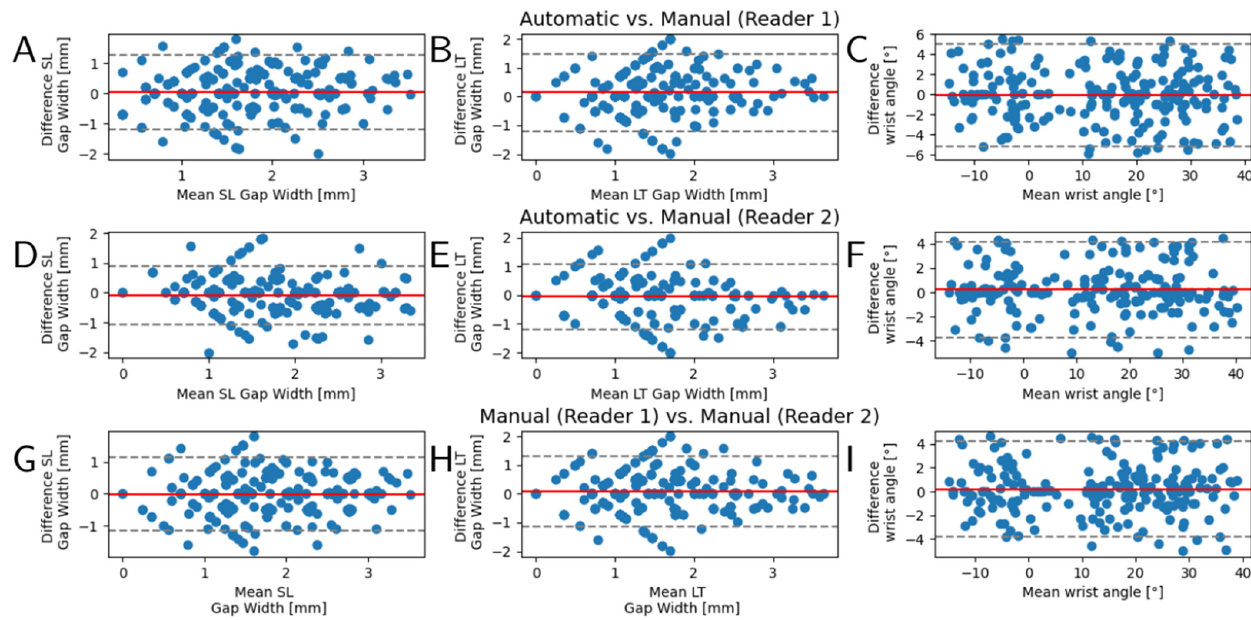
Figure 5. Bland–Altman plots to evaluate inter-method and inter-reader reliability. Automatic segmentations and subse- quently determined diagnostic measures, i.e., scapholunate (SL) gap width ( A , D , G ), lunotriquetral (LT) gap width ( B , E , H ), and wrist angle ( C , F , I ), were evaluated against the manual reference measurements by two radiologists (reader 1, reader 2). Y-axes indicate the respective measures’ inter-method or inter-reader differences, while x-axes indicate the mean measure. Visualized are the 210 values of the test datasets as derived from 15 representative images across the entire range-of-motion. Red lines indicate the mean of the differences and gray dashed lines the 95% confidence intervals.